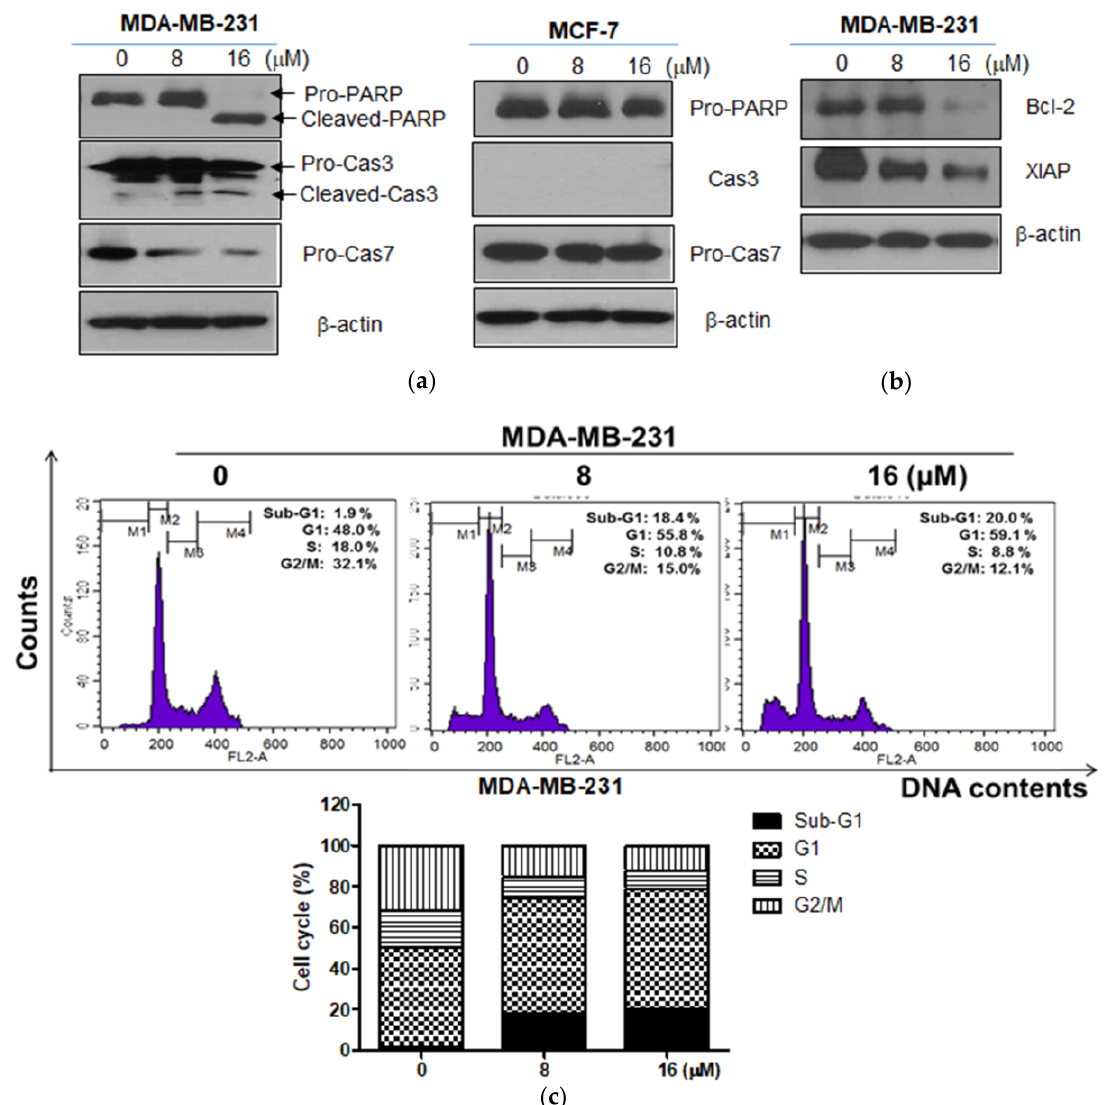
Figure 2. Effect of Moracin D on apoptosis related proteins and apoptosis portion in MDA-MB-231 cells. Human breast cancer cells (MDA-MB-231, MCF-7) were treated with Moracin D for 24 h. ( a ) Cell lysates were prepared and then subjected to Western blotting with antibodies of caspase-3, procaspase-7, and cleaved poly (Adenosine diphosphate ribose (ADP-ribose)) polymerase (PARP). ( b ) MDA-MB-231 cells were treated with Moracin D (0, 8 or 16 μM) for 24 h and subjected to Western blotting for B-cell lymphoma 2 (Bcl-2) and X-linked inhibitor of apoptosis protein (XIAP). ( c ) The stained cells by propidium iodide (PI) were evaluated by fluorescence-activated cell sorting (FACS). The bar graphs show quantification of cell cycle population (%).